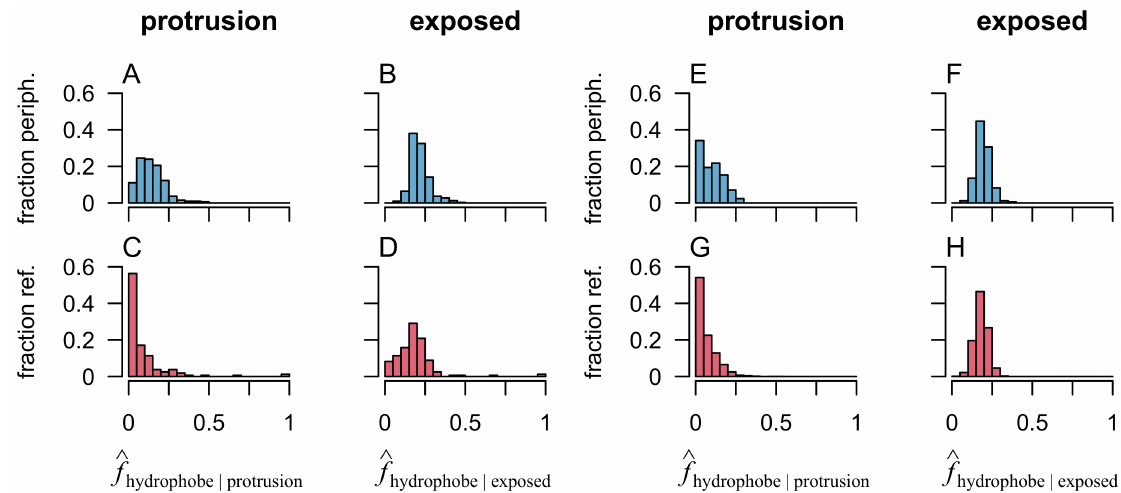
Fig 2. Hydrophobes are more common on protruding positions in peripheral proteins than in the reference sets. The plots show frequencies of hydrophobes on surface amino acids, both on protrusions (A, C, E, G) and among all solvent exposed amino acids (B, D, F, H) for peripheral proteins (blue) and the reference datasets (red). The horizontal axes show the mean fraction (Eq 1) of protrusions or solvent exposed amino-acids that are hydrophobic. The vertical axis shows the fraction of protein families for each set. Plots A-D show the comparison between the data sets ‘Peripheral’ and ‘Non-binding surfaces’, and E-H the comparison between ‘Peripheral-P’ and ‘Reference Proteins’.